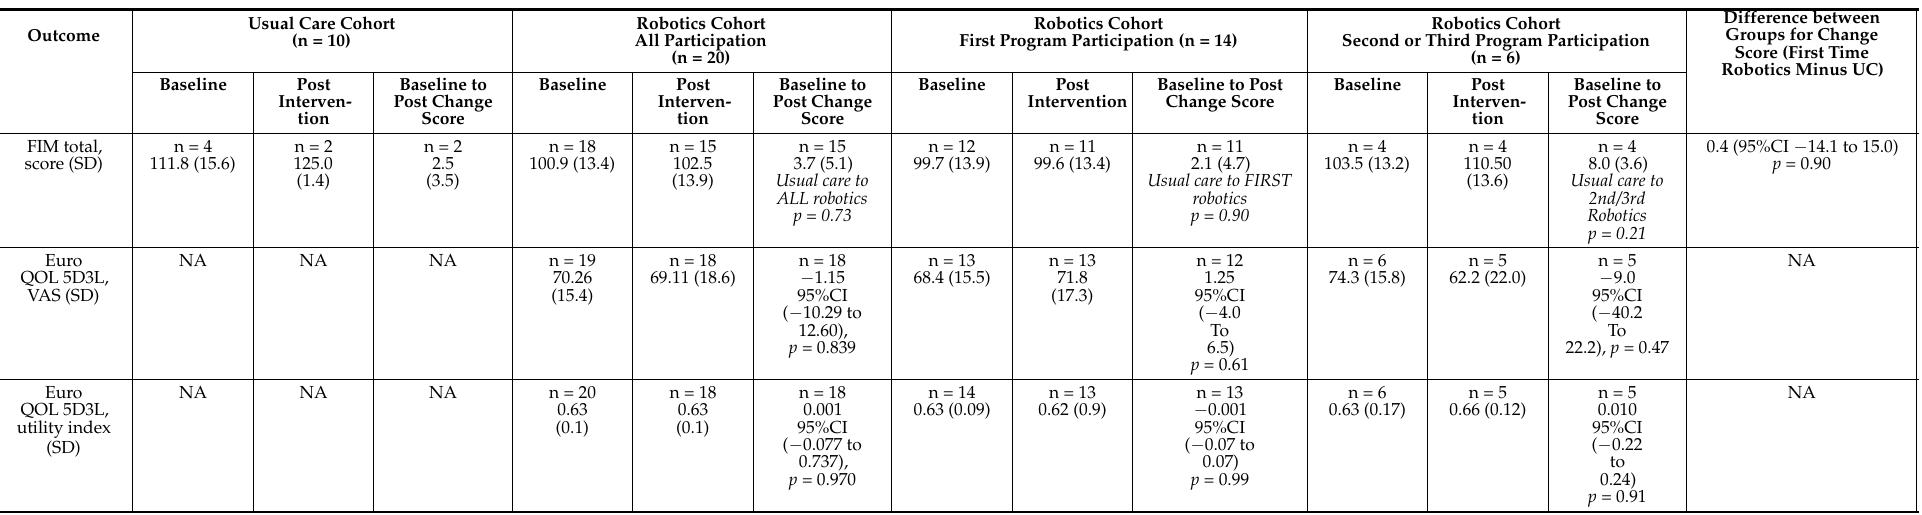
Table 4. Patient